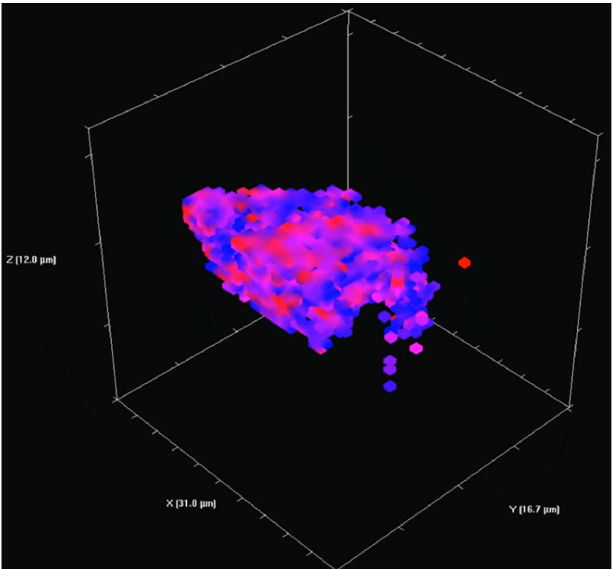
Figure 11. The 3D model of the chosen magnetite was generated based on the 3D Raman mapping, selecting 661 cm − 1 as a criterion.